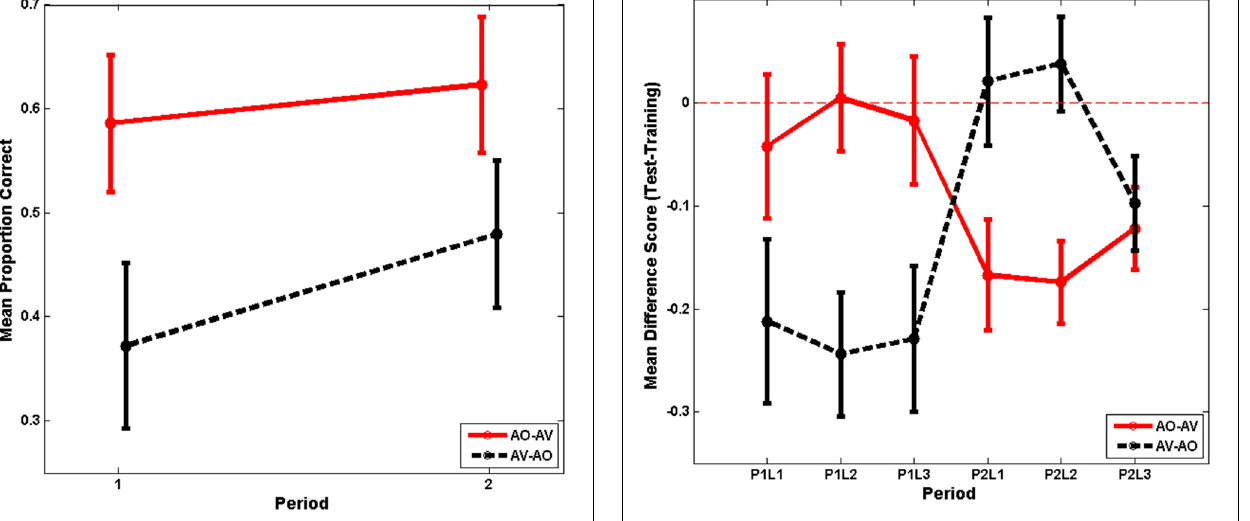
FIGURE 5 | Experiment-1 mean test scores with standard errors of the mean. Period-1 test scores were lower for AV-trained participants, whose scores improved significantly in Period 2.